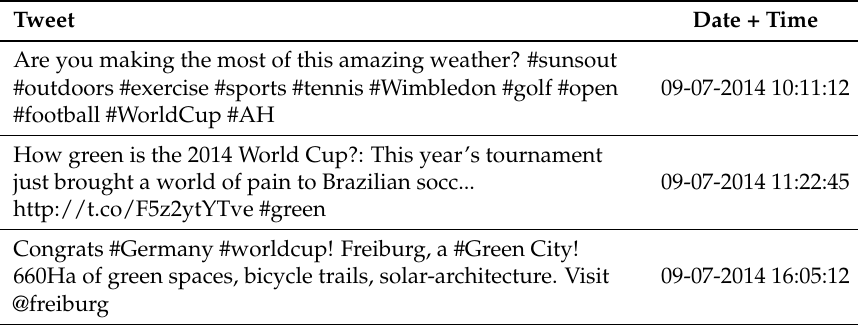
Table 9. World Cup tweets published on 9 July 2014. Tweet Date +